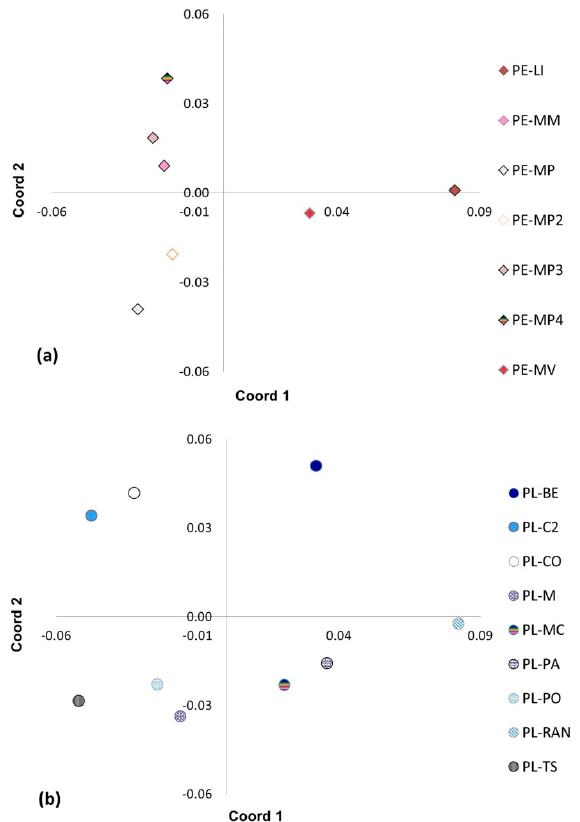
Figure 5. Results of Principal Coordinate Analysis ( PCoA ) at the stand level, with AFLP (amplified fragment length polymorphisms). For Pinus engelmannii ( a ) and Pinus leiophylla ( b ) the first two coordinates of PCoA together explained 75.78% and 64.95%, respectively, of the variation. Seed stands: La Lisuda (PE ‐ Li), Mesa de Mingarreta (PE ‐ MM), Mesa de Perdederos 1 (PE ‐ MP), Mesa de Perdederos 2 (PE ‐ MP2), Mesa de Perdederos 3 (PE ‐ MP3), Mesa de Perdederos 4 (PE ‐ MP4), La Mesa de Veracruz (PE ‐ MV), Bajío (PL ‐ BE), Coloradas (PL ‐ C2), Cócono (PL ‐ CO), Maguey (PL ‐ M), Mesa de Cristo (PL ‐ MC), Patio (PL ‐ PA), Polvorín (PL ‐ PO), Rancho (PL ‐ RAN), and Tijera de Salsipuedes (PL ‐ TS).